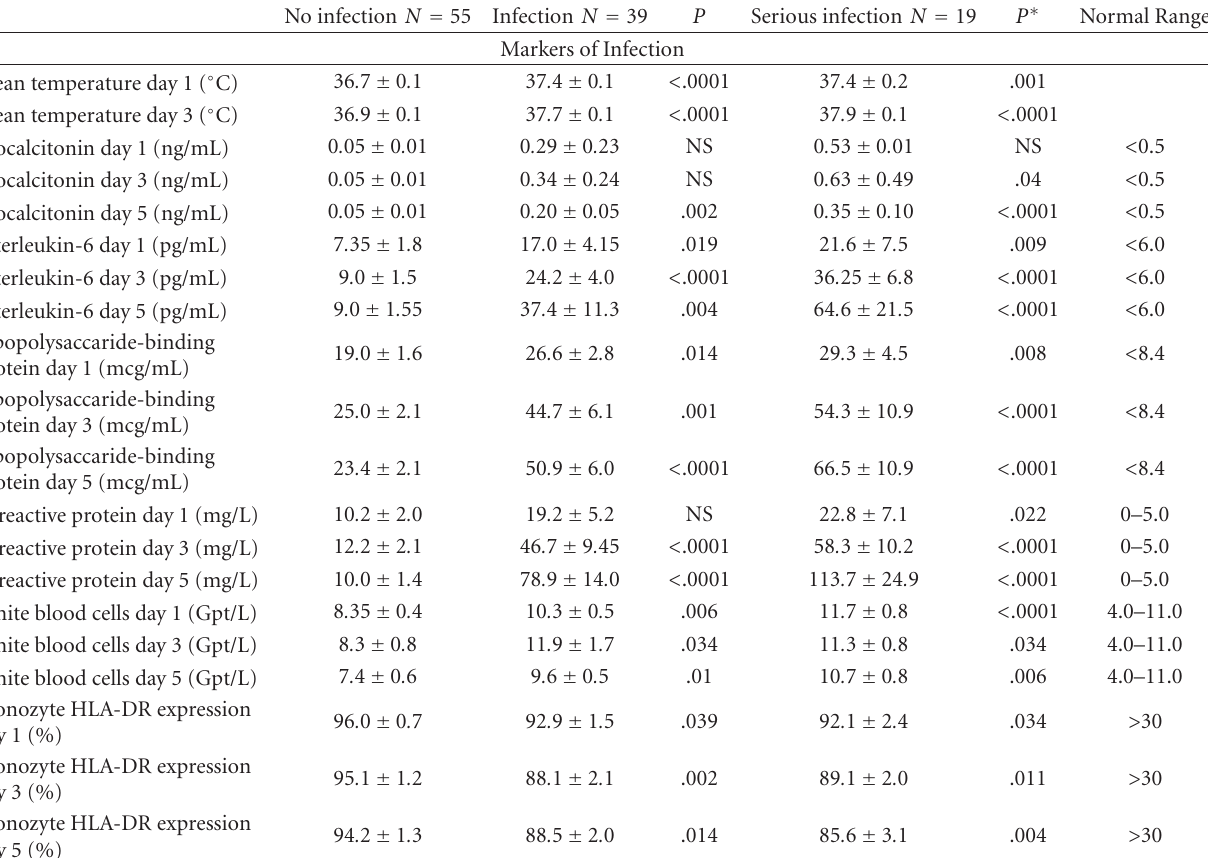
Table 2: Univariate associations of laboratory markers of infection with the development of an infection and serious infection during the hospital stay.